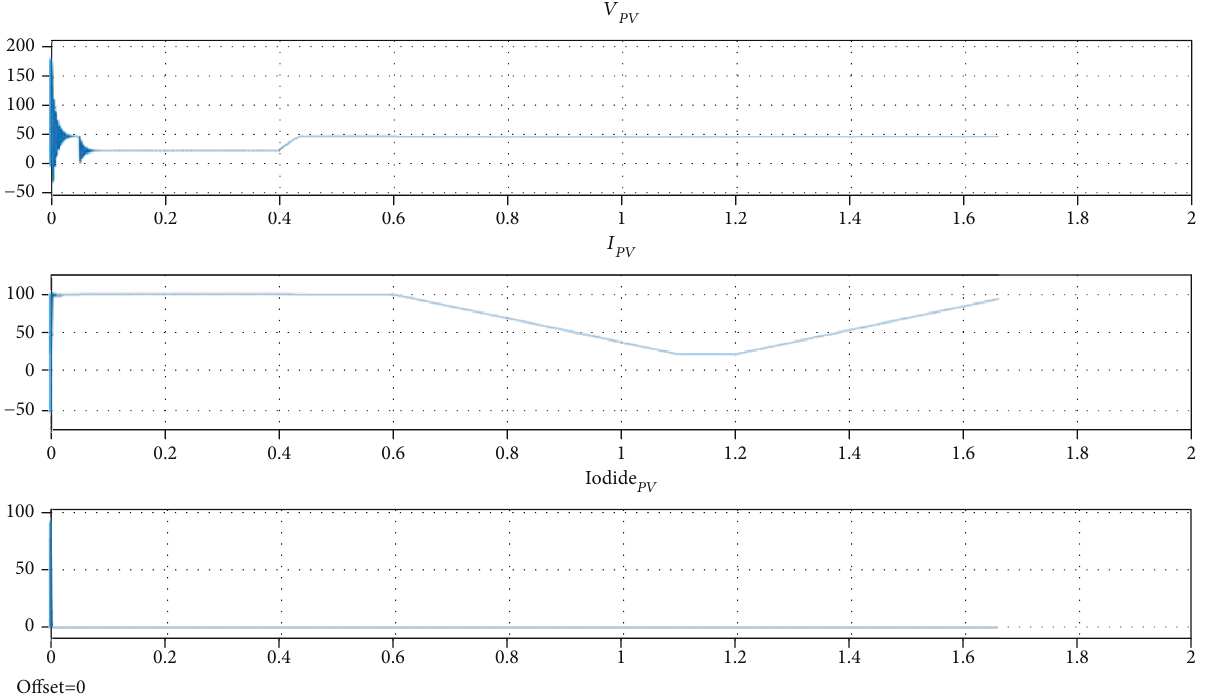
Figure 17: PV array voltage and